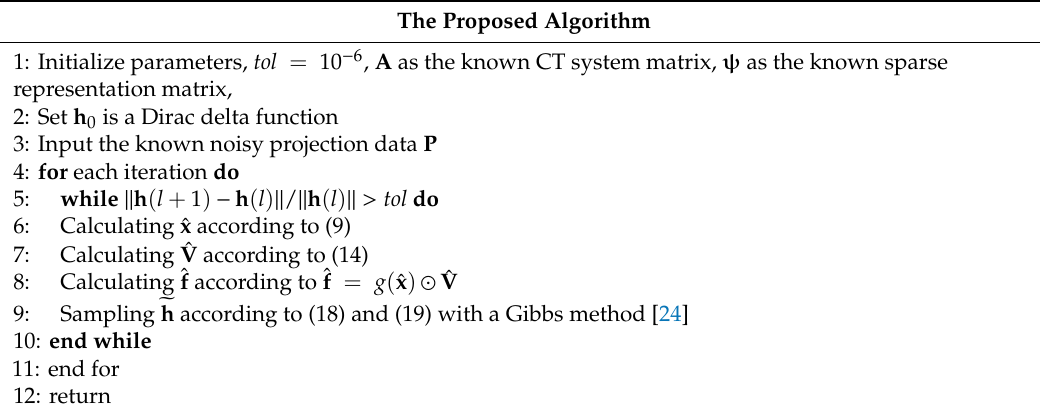
Table 1. The flow of the proposed algorithm. The Proposed